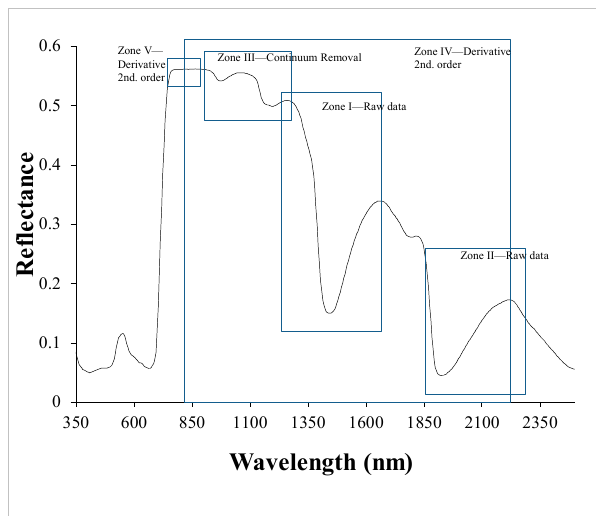
Figure 6. Relevant zones obtained in this study.